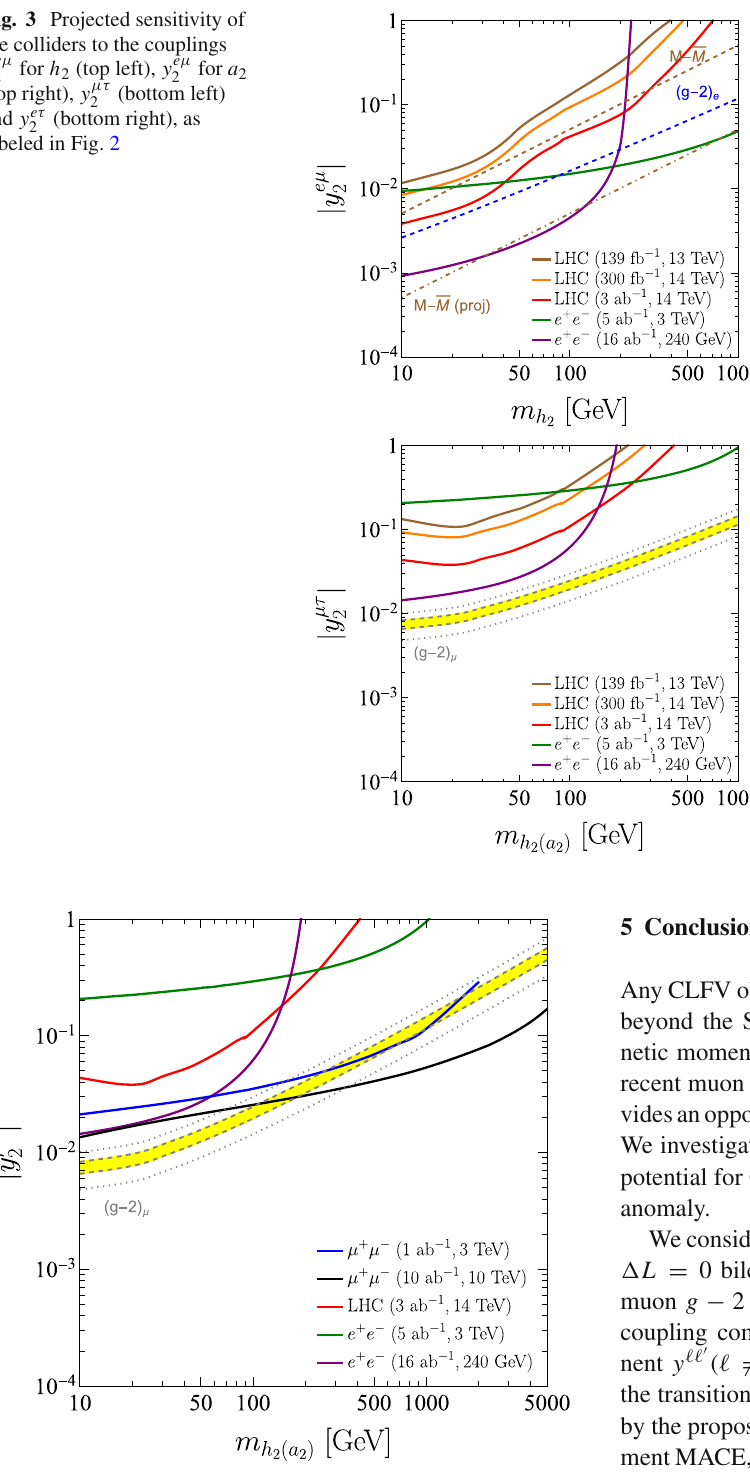
Fig. 4 Projected sensitivity of two different configurations for a muon μτ collidertothecoupling y andtheregionfavoredbythemuonAMMin 2 comparisontotheultimateLHCsensitivityandproposed e + e −